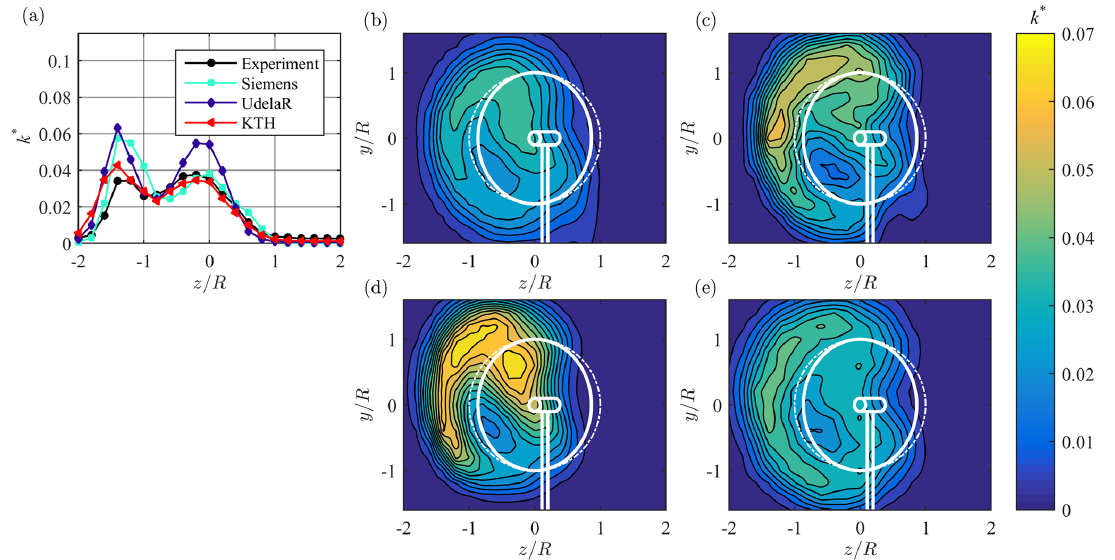
Figure 16. (a) Line plot at hub height and (b–e) contour plots for normalized turbulent kinetic energy (TKE) k ∗ in the wake 3 D behind ForWind turbine, from (b) experiments, (c) Siemens, (d) UdelaR, and (e) KTH. The white lines represent the turbine rotor, nacelle, and tower; solid lines γ = 30 ◦ ; dashed lines γ = 0 ◦ . ), and their differences to the Table 6. Comparison parameters: skew angle ( ξ ), wake deflection ( δ ), and available power in the wake ( P ∗ wake measurements. Statistical performance measures are NMSE and r for u ∗ , v ∗ , and k ∗ at 3 D and 6 D behind upstream ForWind turbine. Institution Skew Deflection Difference P ∗ Difference NMSE u r u r v NMSE k r k wake angle ( z/R ) ( z/R ) (–) (%) N 3 D Experiments 4.10 ◦